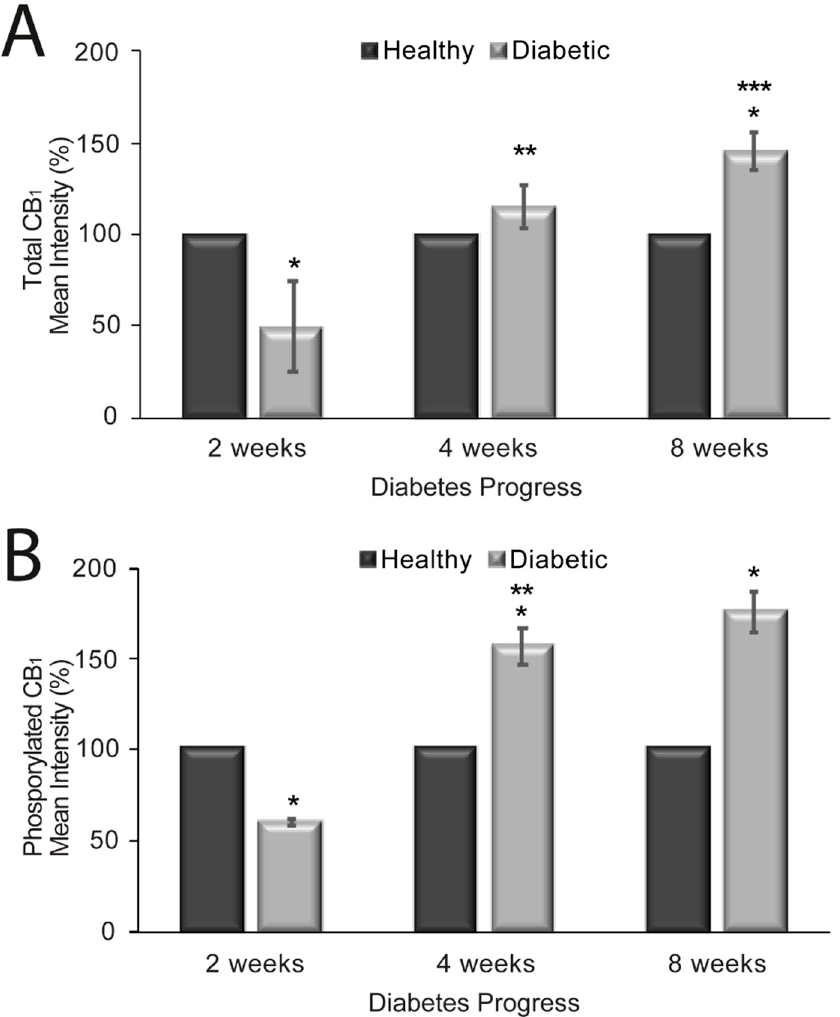
Figure 2. Mean intensity of total CB 1 receptors ( A ) and phosphorylated CB 1 receptors ( B ) in healthy and diabetic rat aortas. n = 10 image stacks for each. * Significant ( p < 0.05) change in CB 1 mean intensity in diabetic vs. healthy aortic rings at different time points. ** Significant difference ( p < 0.05) in CB 1 mean intensity between 2 and 4 weeks. *** Significant difference ( p < 0.05) in CB 1 mean intensity between 4 and 8 weeks.